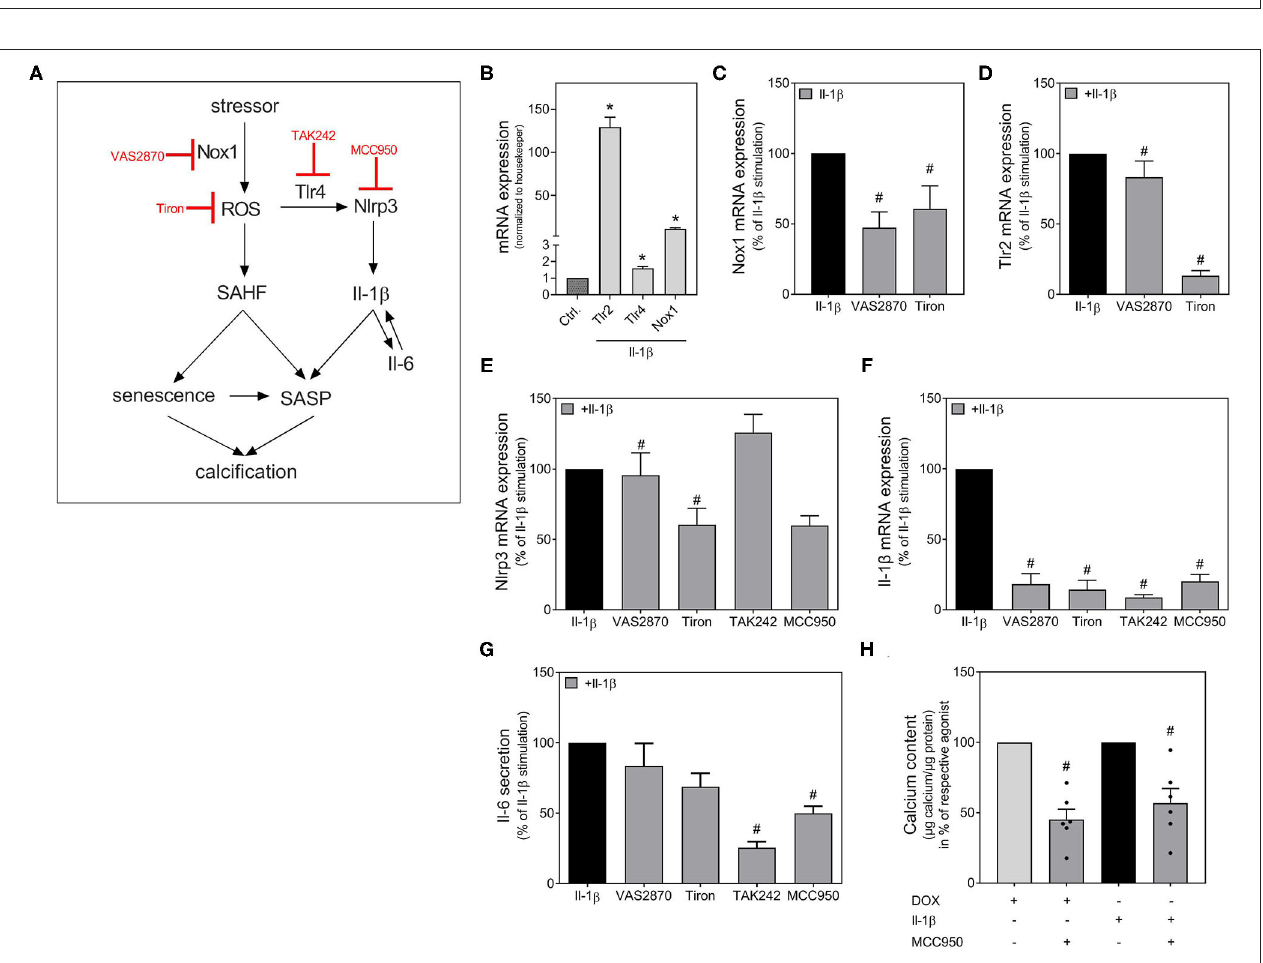
FIGURE 6 | Possible signaling pathways in Nlrp3 dependent calcification. Scheme with inhibitors used (A) . VSMC were stimulated for 48h (B–G) or 14 d (H) with Il-1 β (100ng/ml), DOX (100 nmol/l), VAS2870 (10 µ M), MCC950 (50 µ M), TAK242 (10 µ M) or Tiron (10mM) as indicated. mRNA expression was measured with quantitative real-time PCR (B–F) . Measured thresholds of the respective targets were normalized to the corresponding average threshold of housekeeper genes actin and Gapdh before normalization to control (B–F) . Secretion of Il-6 was measured with Luminex TM and normalized to protein content ( µ g) (G) . Calcium content was quantified with o -cresolphthalein and normalized to protein content ( µ g) (H) . Data represent mean ± SEM, n ≥ 3, * p < 0.05 vs. Control, # p < 0.05 vs. Respective agonist (100ng/ml Il-1 β or 100 nmol/l DOX).